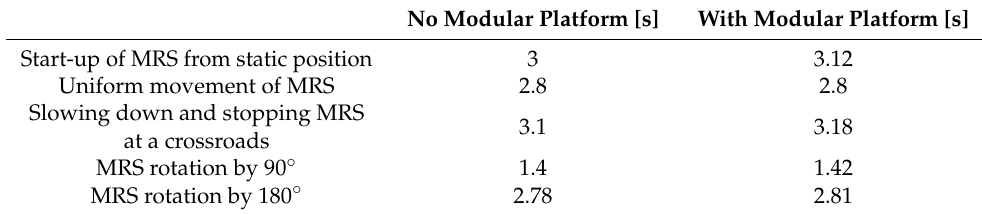
Table 1. Duration and types of